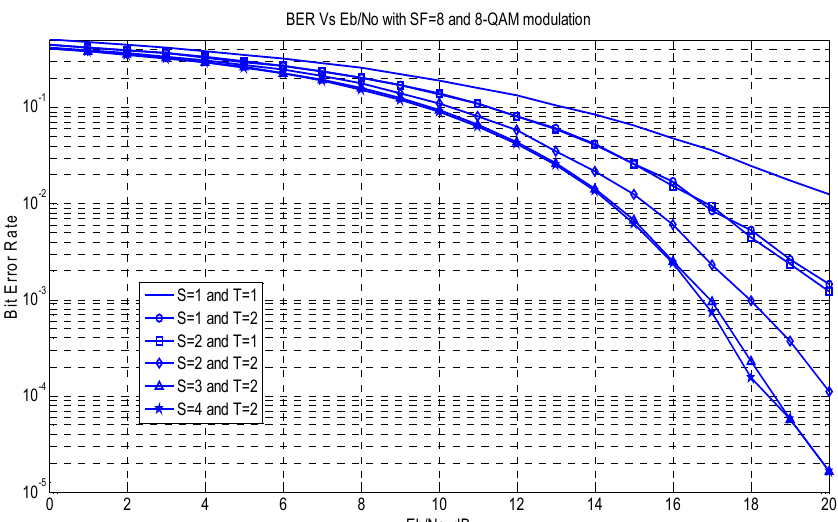
Figure 8. Bit error rate (BER) performance of the MC-DS-CDMA